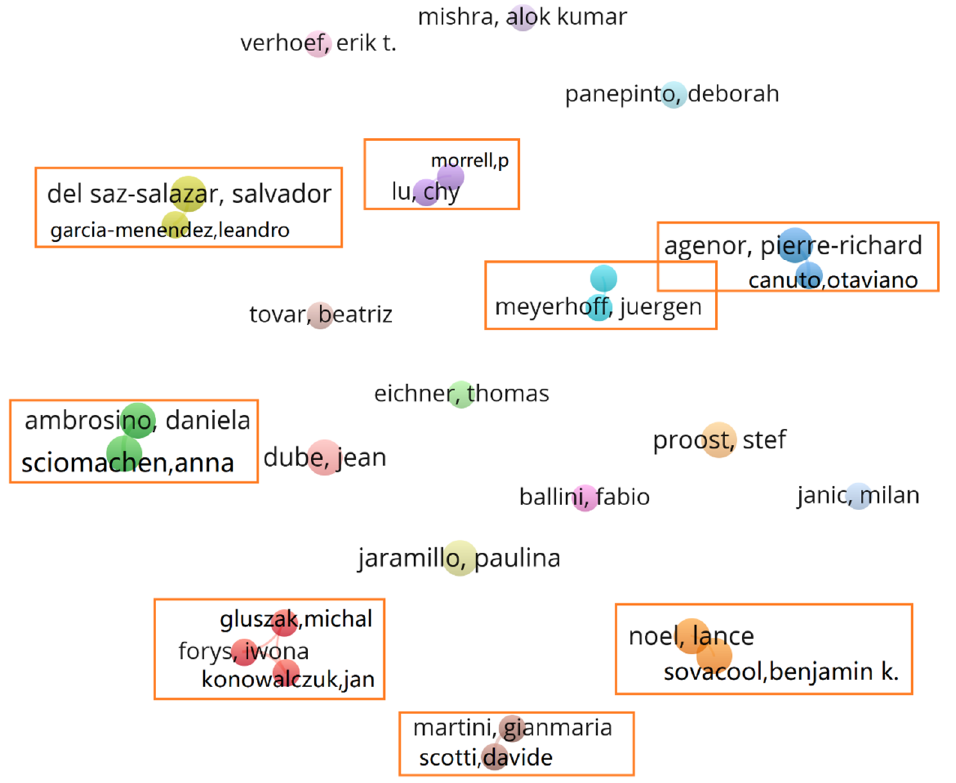
Figure 4. Collaboration network of authors in infrastructure externalities research.